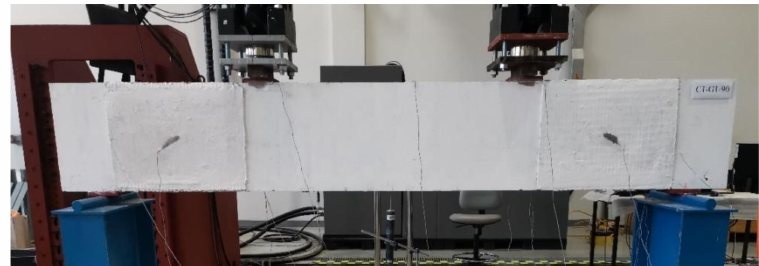
Figure 5. A test in